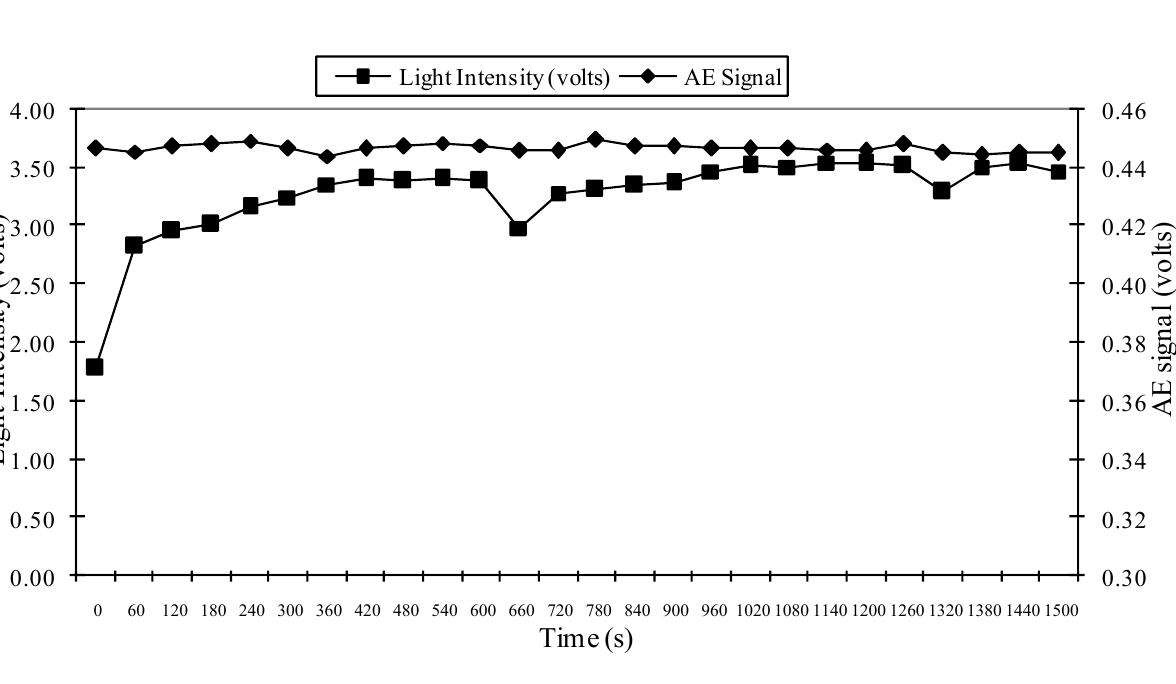
Figure 5. Wenglor® optical sensor and resonant acoustic emission sensor signals comparison when cleaning with CO flakes during abrasive 2